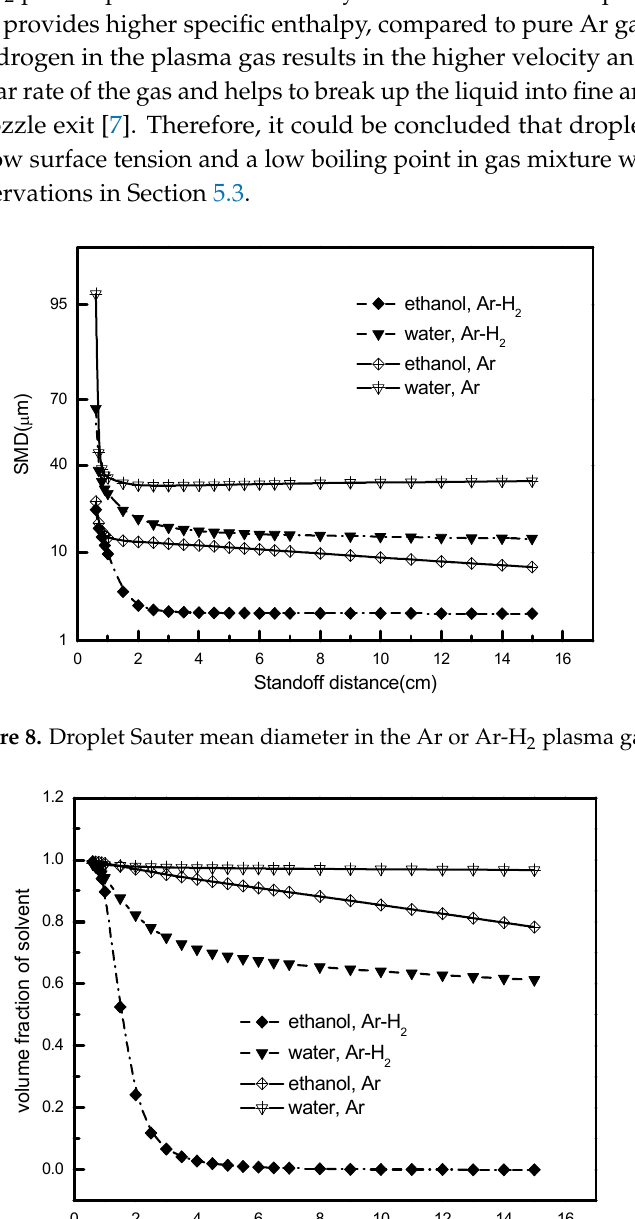
Figure 9. Evolution of the solvent volume fraction in the Ar or Ar ‐ H 2 plasma gas.